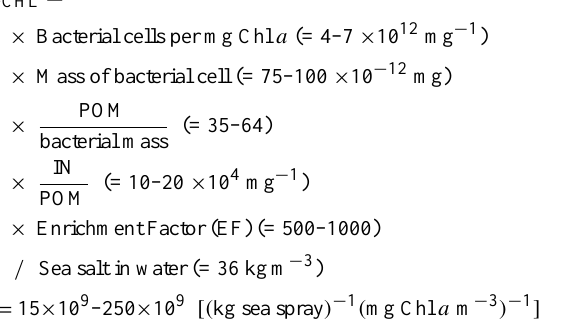
α CHL = × Bacterial cells per mg Chl a (= 4–7 × 10 12 mg − 1